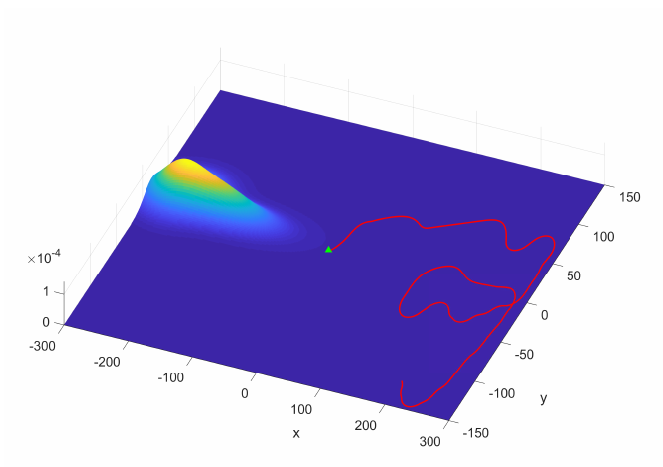
Figure 4. The contour plot of the probability map (the particles fitted by Gaussian Mixture Model(GMM)), the current position of the mobile sensor platform marked by a blue triangle at the time k = 1020 using the infotaxis scheme.